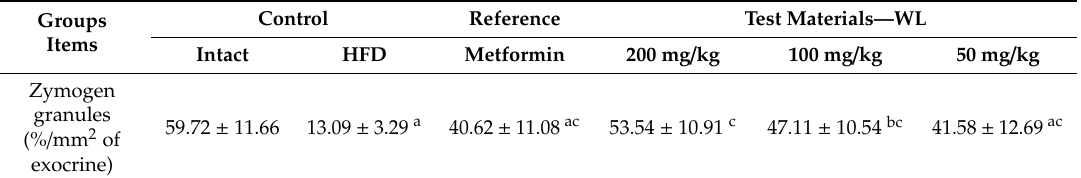
Table 4. Changes in pancreas zymogen granule content in NFD or HFD supplied mice.